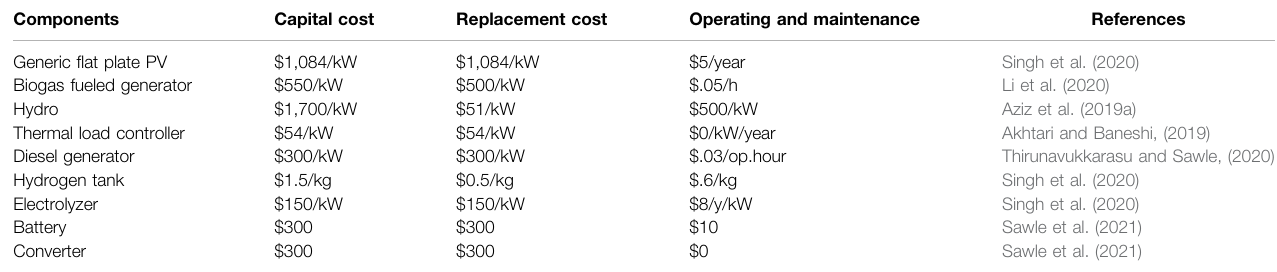
TABLE 2 | Economic speci fi cations of